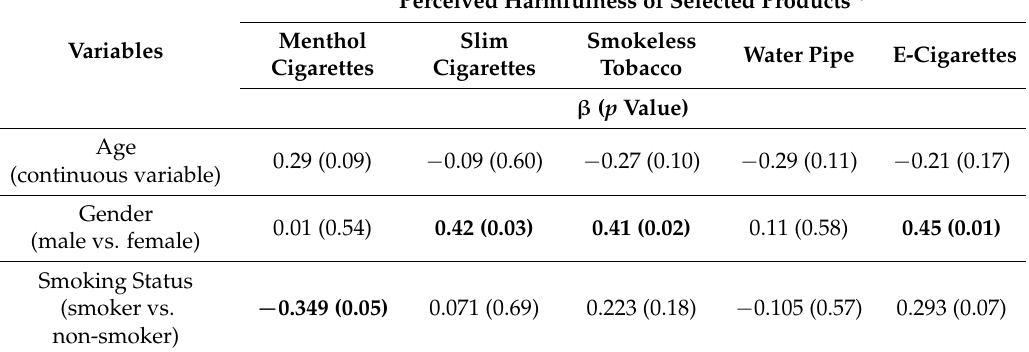
Table 4. Associations between the perceived harmfulness of selected tobacco/nicotine products and age, gender and cigarette smoking